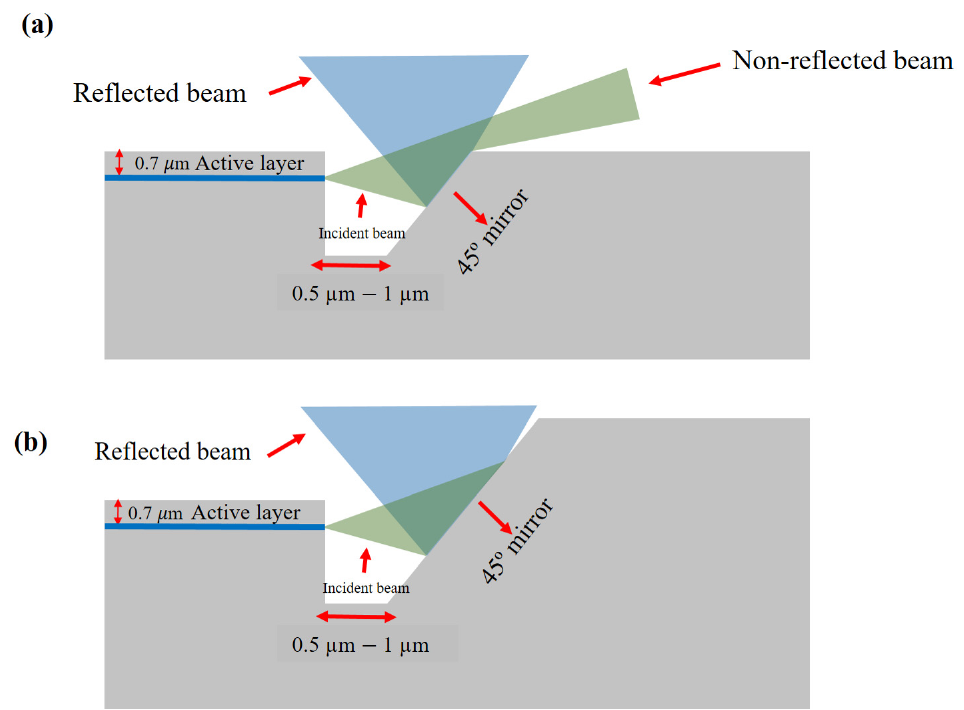
Figure 1. The simplest geometry of the laser structure with etched vertical laser mirror and deflective 45° mirror ( a ) device made on planar structure ( b ) laser fabricated below the surface of the wafer.